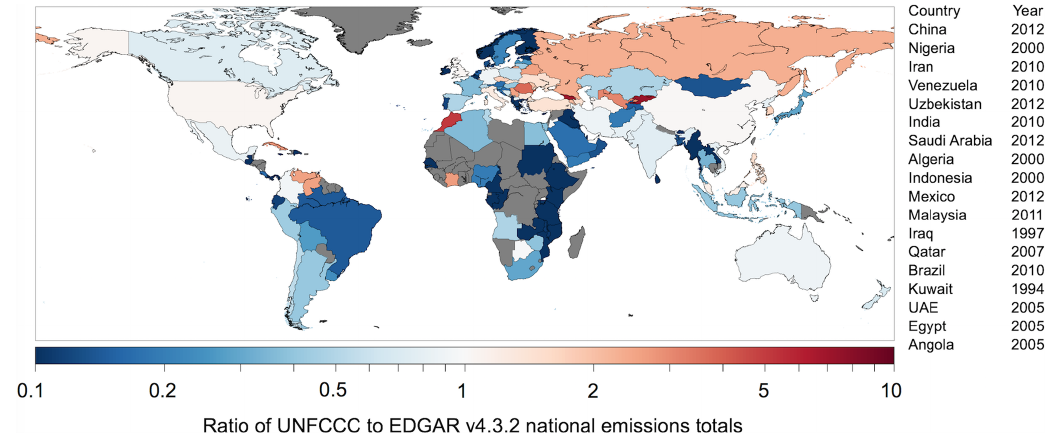
Figure 6. Comparison of national methane emissions from fuel exploitation (sum of oil, gas, and coal) reported by individual countries to the UNFCCC (2019) and estimated by the EDGAR v4.3.2 inventory (European Commission, 2017). The figure shows the ratio of UNFCCC to EDGAR v4.3.2 national emissions, with warmer colors indicating higher UNFCCC emissions. Emissions are taken from the most recent year reported to the UNFCCC prior to or in 2012 and compared to EDGAR for the same year. The reporting year for non-Annex I countries with emissions greater than 1Tga − 1 in either inventory is shown to the right. Countries in dark grey do not report fuel exploitation emissions to the UNFCCC or have zero